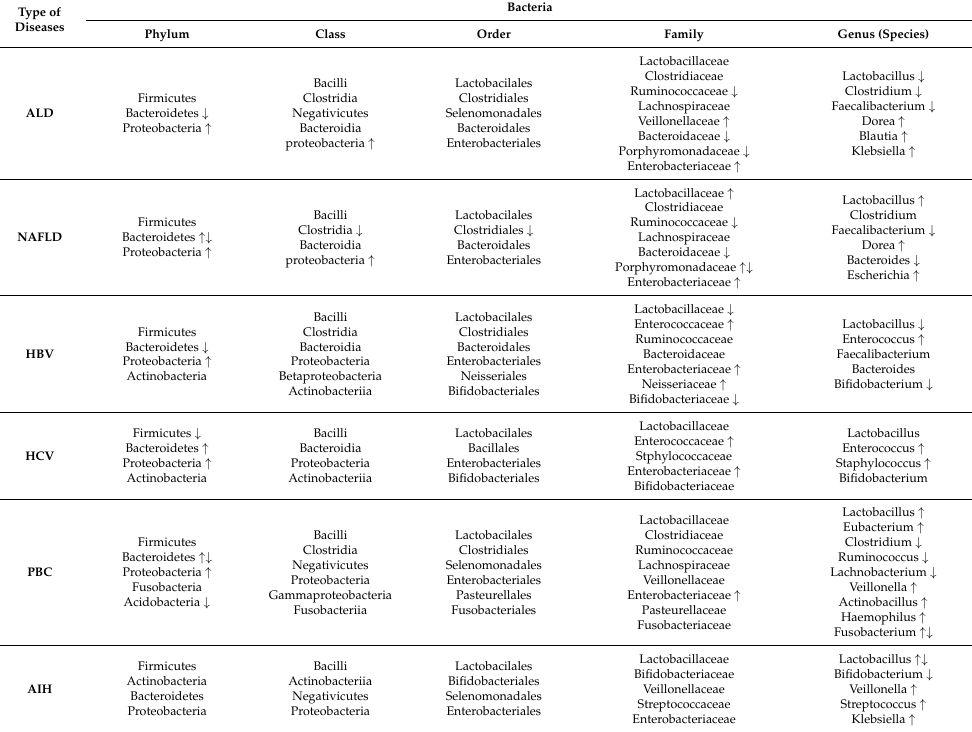
Table 1. Representative changes in microbial diversity according to types of